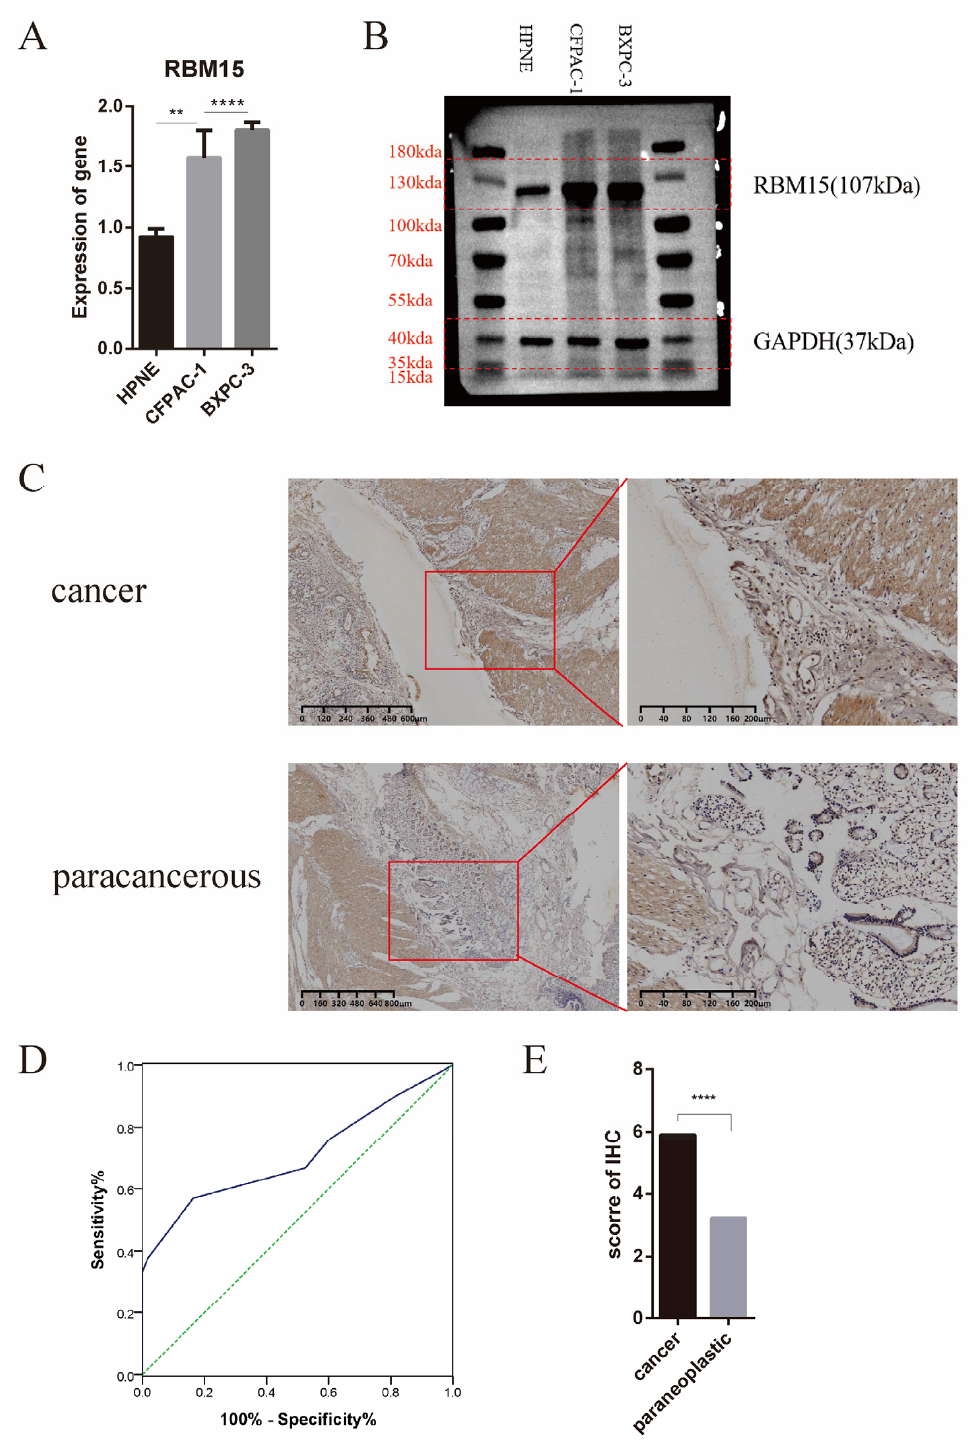
Figure 6. ( A ) Gene expression of RBM15 in cell lines; ( B ) Protein expression of RBM15; ( C ) Immuno- histochemical experiments; ( D ) Receiver operating characteristic curve for different immunohisto- chemical scores; ( E ) Distribution of immunohistochemical scores (** p < 0.01; **** p < 0.0001). Original blot see Supplementary File S1.